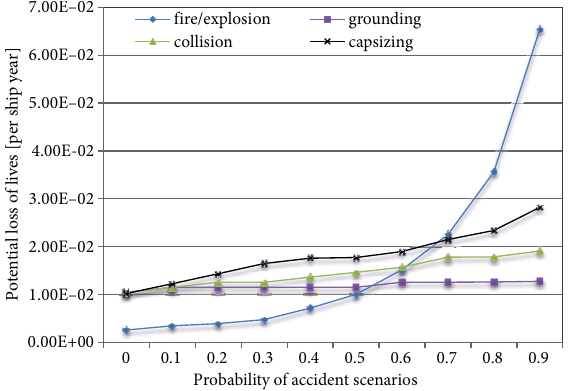
Fig. 6. Sensitivity analysis of four risk factors over the probability of RoPax risk